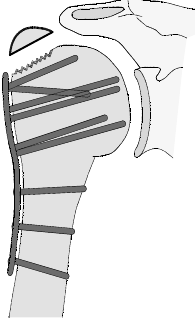
Figure 12. Complication Type 2b. Sample image. Following angular stable plate osteosynthesis, the